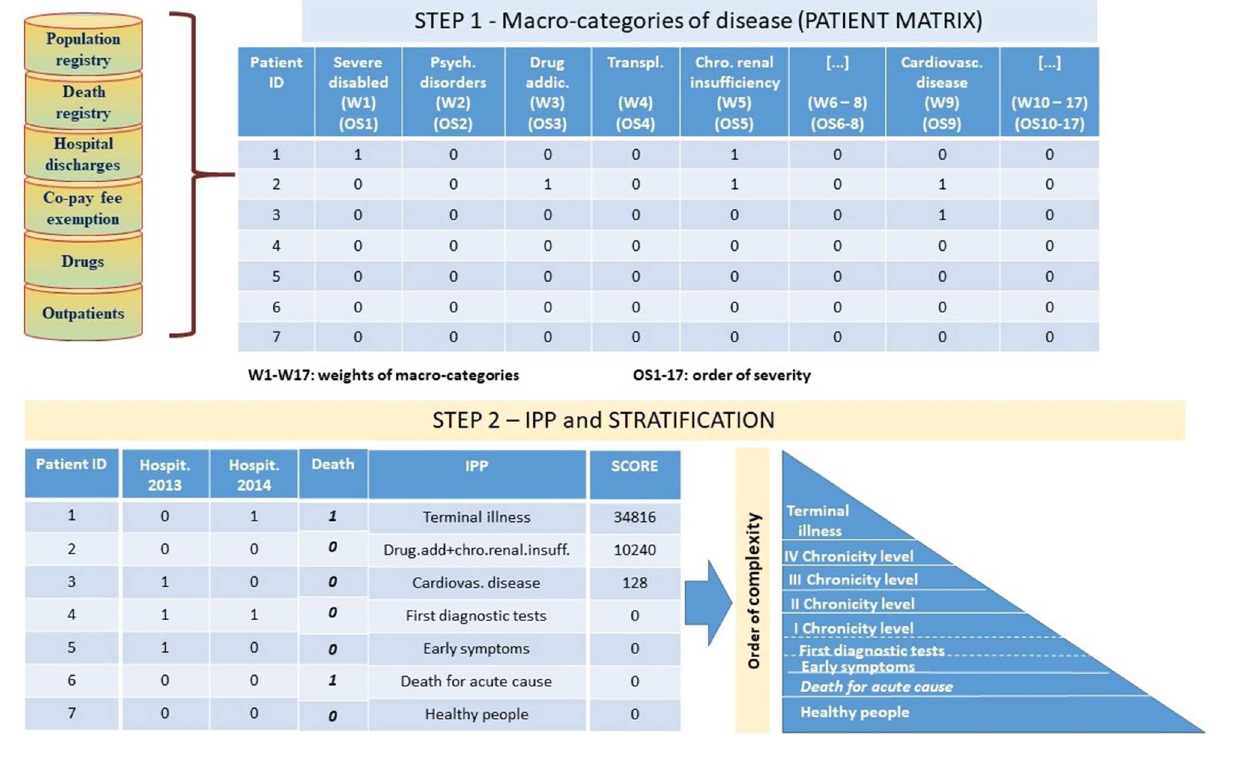
FIGURE 1 | The IPP